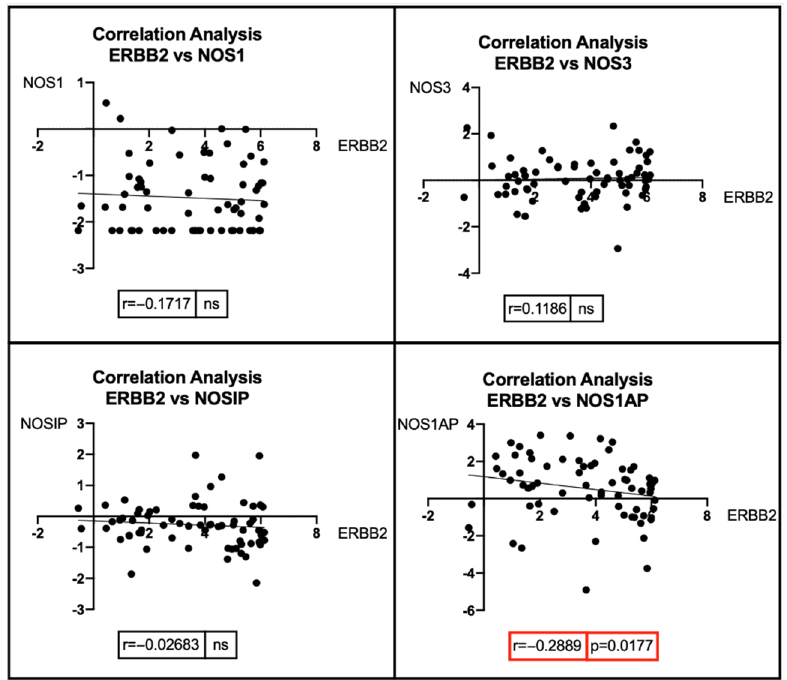
Figure 5. Correlation analyses between the expression levels of ErbB2 and NOS genes in TCGA breast cancer patients with HER2 amplification. Each black dot represents a cancer patient.